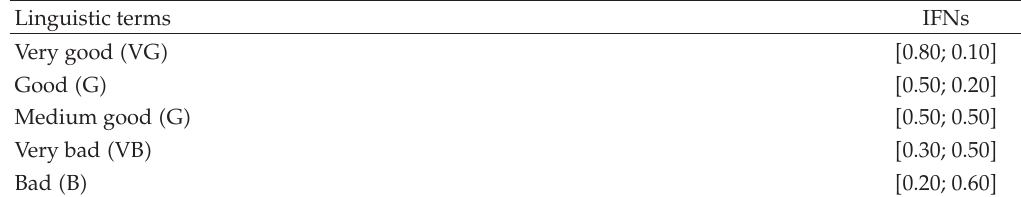
Table 5: The linguistic terms for the importance of the criteria.